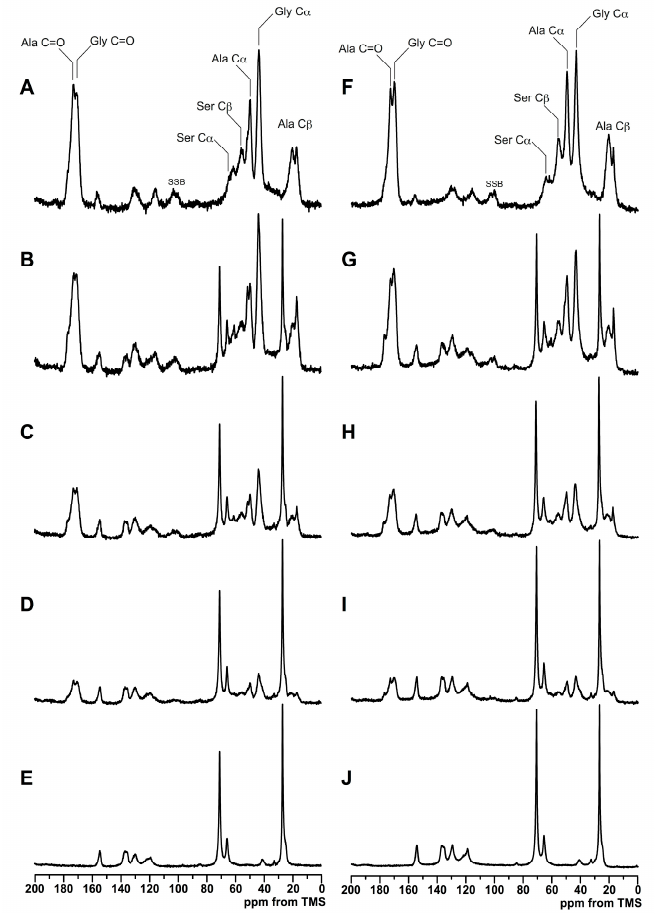
Figure 3. 13 C CP/MAS NMR spectra of non-woven sheets in dry ( A – E ) and wet ( F – J ) samples. SF/PU = 10/0 ( A , F ); 7/3 ( B , G ); 5/5 ( C , H ); 3/7 ( D , I ); and 0/10 ( E , J ); respectively. ( A , F ); 7/3 ( B , G ); 5/5 ( C , H ); 3/7 ( D , I ); and 0/10 ( E , J );